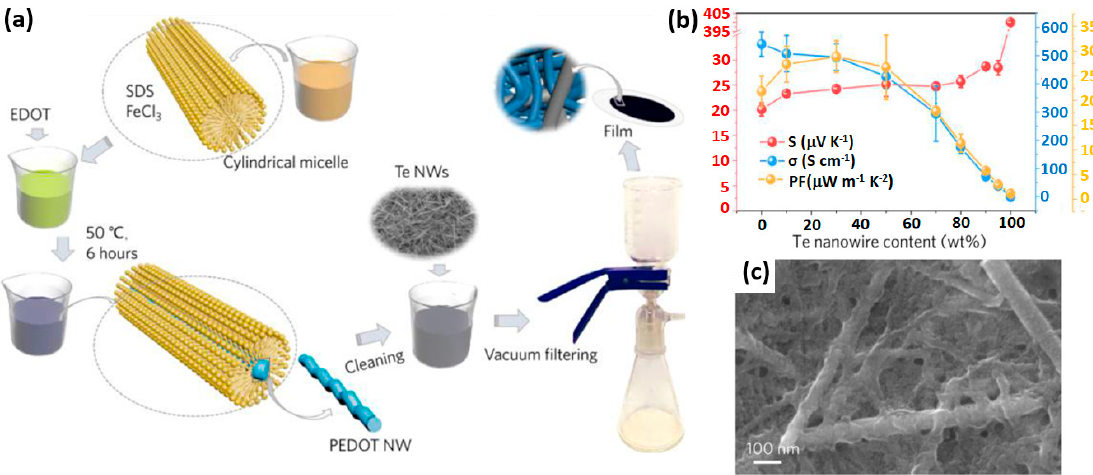
Figure 13. ( a ) Schematic illustration of the fabrication process of the Te nanowire/PEDOT nanowire composite films. ( b ) Measured thermoelectric properties including S, σ and PF of the composites relative to the mass fraction of Te nanowires. ( c ) SEM image of the surface morphology of 70 wt% Te nanowire/PEDOT nanowire composite films. Readapted with permission from American Chemical Society [101].